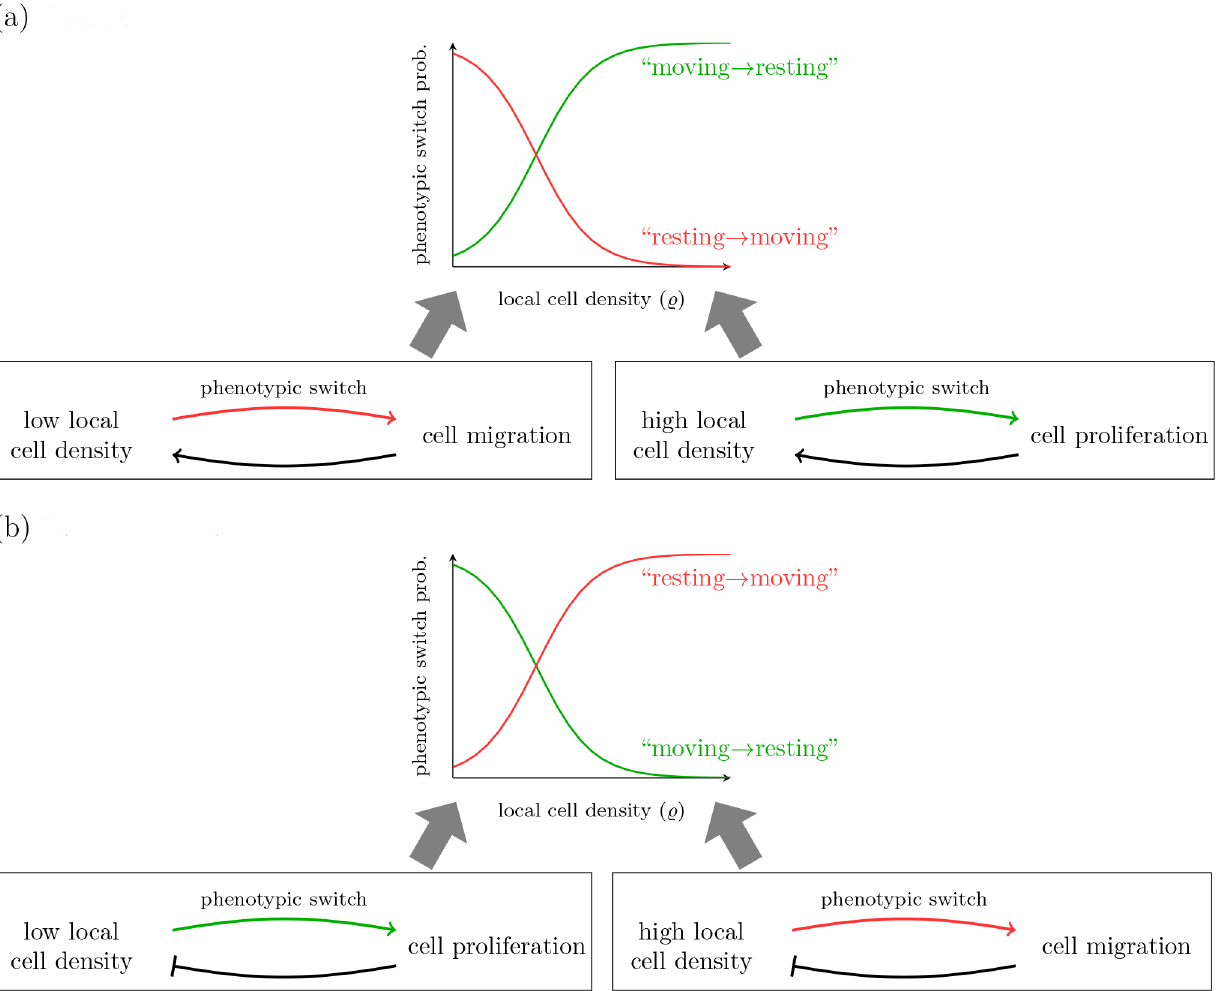
Fig 4. Sketch of the feedback mechanisms on single cell behavior (proliferative or migratory) for the different types of phenotypic plasticity (attractive or repulsive). (a) In the attractive case, the positive feedback between cell proliferation and high local cell density results in population persistence. However, positive feedback between cell migration and low local cell density might lead to population extinction if cell death overbalances replication. (b) In the repulsive case, the negative feedback mechanism on the cell scale leads to a balance of the population growth.